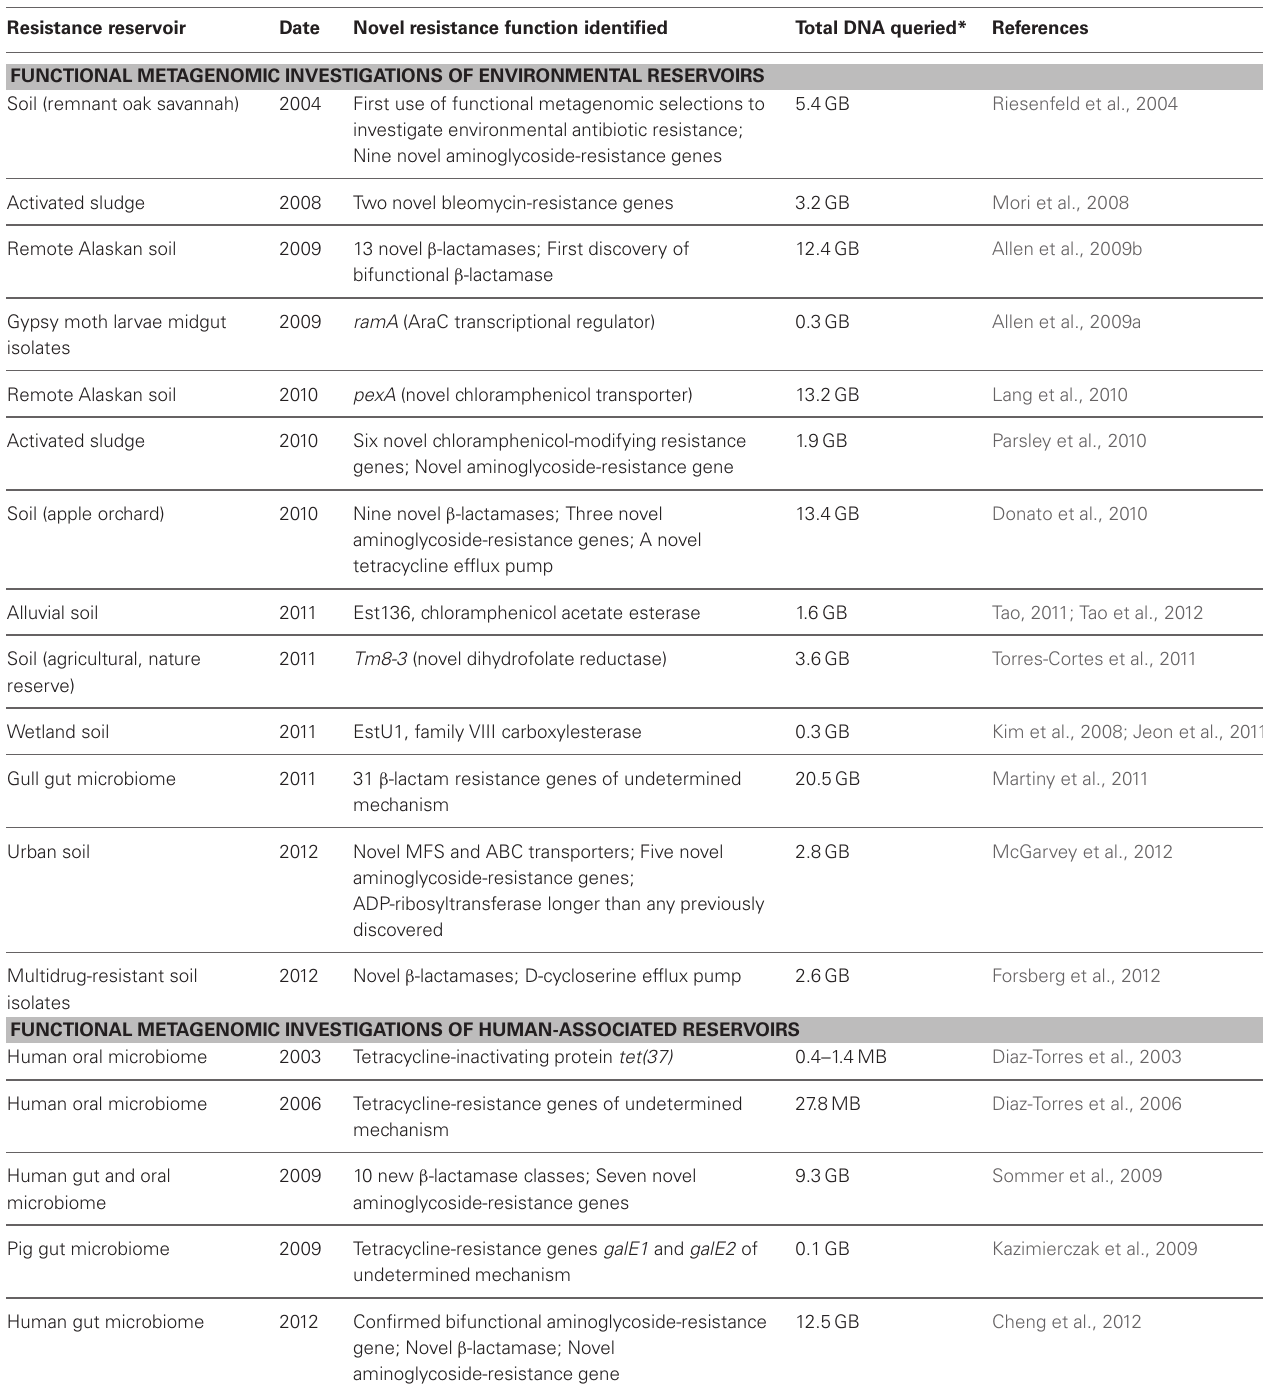
Table 1 | Functional metagenomic investigations of antibiotic resistance